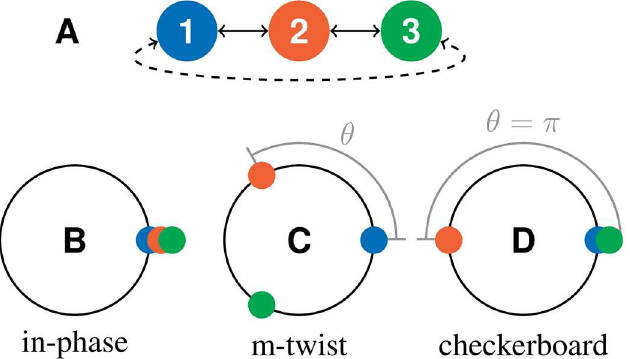
Fig 4. m -twist synchronized states. (A) Couplingtopologies for a system of 3 mutually coupledDPLLs. (B– D) Synchronized states with constant collectivefrequencyand constant phase relationbetweenthe oscillators for a system of three mutually coupledoscillatorswith periodic(cases B,C) or open boundaryconditions (cases B,D): (B) in-phase synchronizedstate, (C) m-twist synchronizedstate and (D) checkerboard synchronized state.